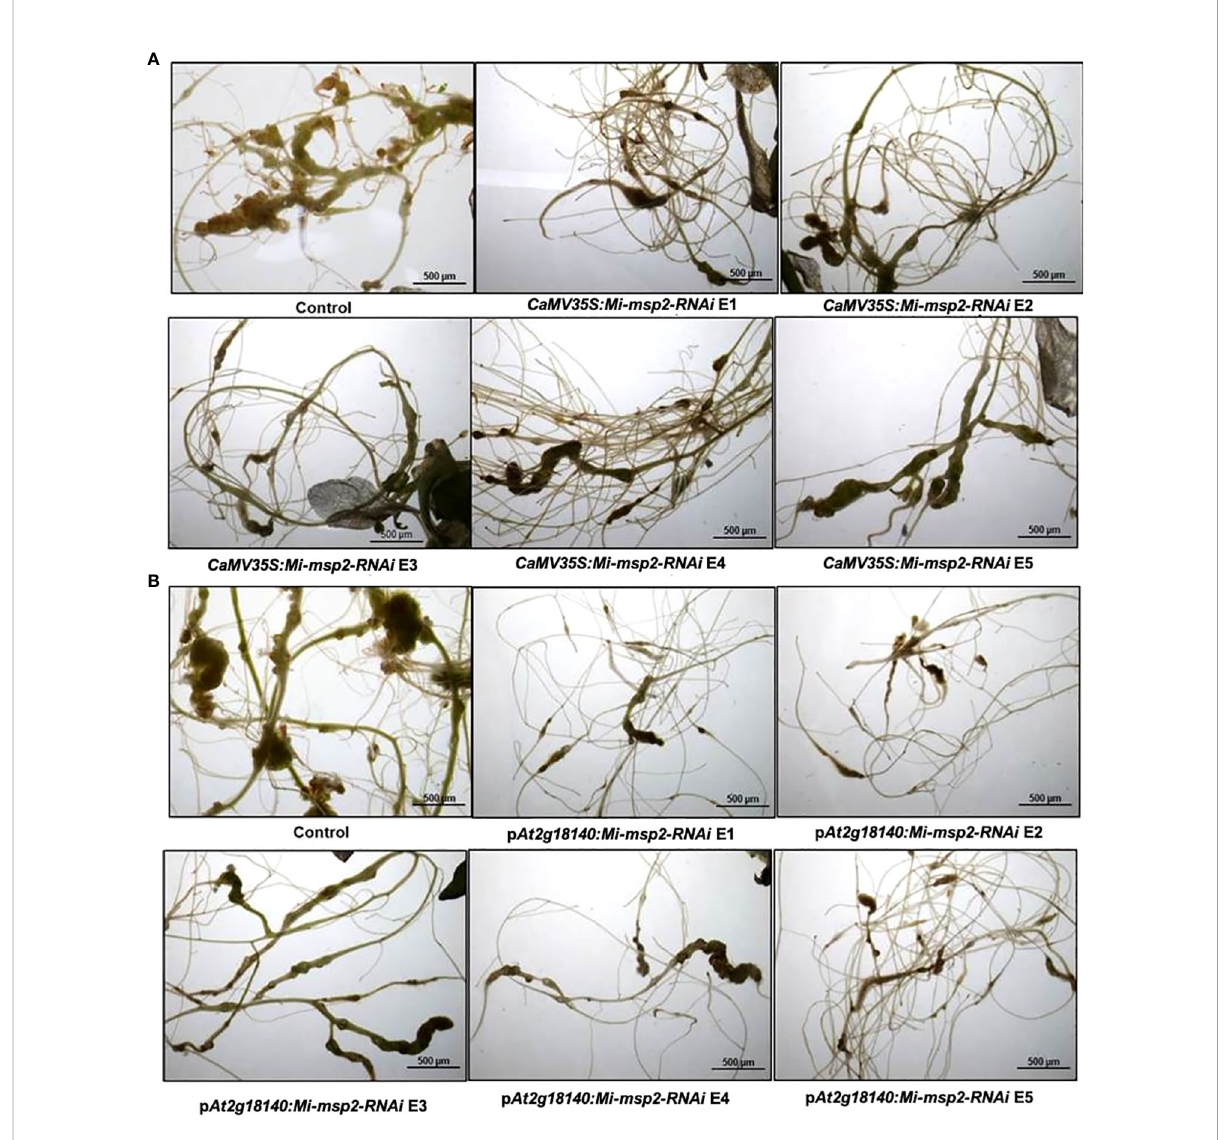
FIGURE 5 Representative images of M. incognita -infected Arabidopsis thaliana roots of control and RNAi plants. (A) Roots of a control plant compared with CaMV35S::Mi-msp2-RNAi RNAi lines ( CaMV35S::Mi-msp2-RNAi E1, CaMV35S::Mi-msp2-RNAi E2, CaMV35S::Mi-msp2-RNAi E3, CaMV35S:: Mi-msp2-RNAi E4 and CaMV35S::Mi-msp2-RNAi E5) and (B) Roots of a control plant compared with p At2g18140::Mi-msp2-RNAi RNAi lines (p At2g18140::Mi-msp2-RNAi E1, p At2g18140::Mi-msp2-RNAi E2, p At2g18140::Mi-msp2-RNAi E3, p At2g18140::Mi-msp2-RNAi E4 and p At2g18140::Mi-msp2-RNAi